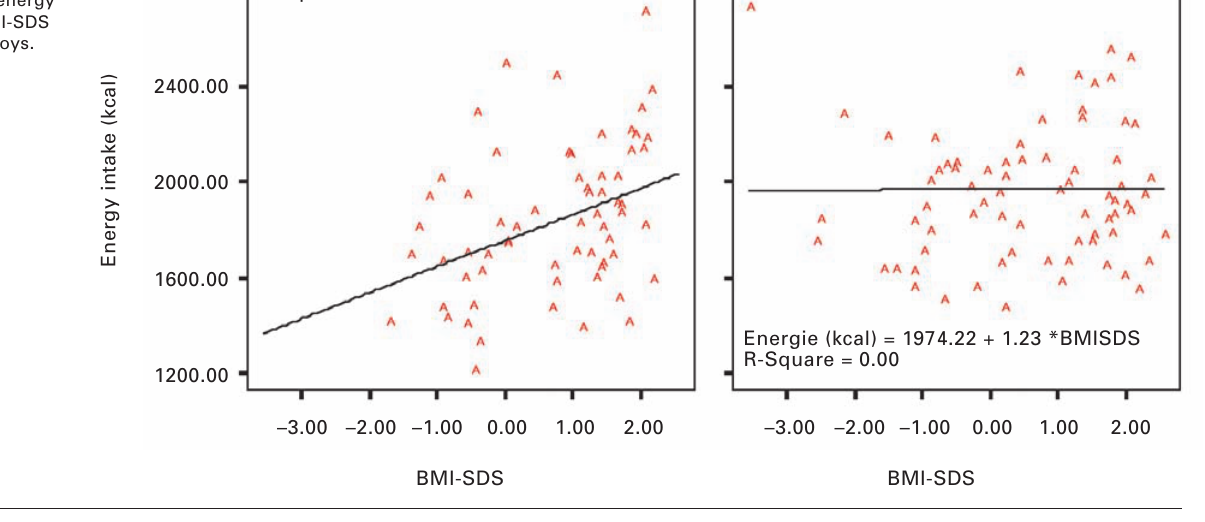
Scatterplot (including regression line) showing the correla- tion between energy intake and BMI-SDS for girls and boys.